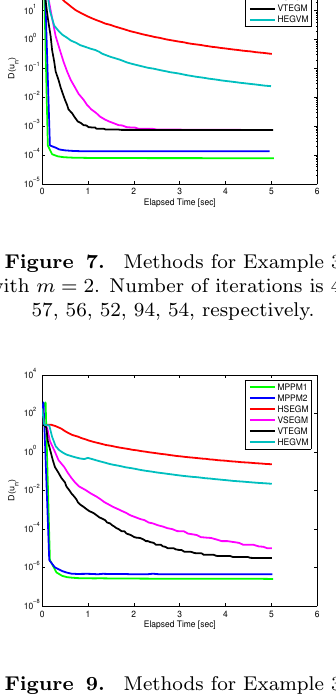
Figure 8. Methods for Example 3 with m = 3. Number of iterations is 55, 58, 56, 56, 108, 55, respectively.